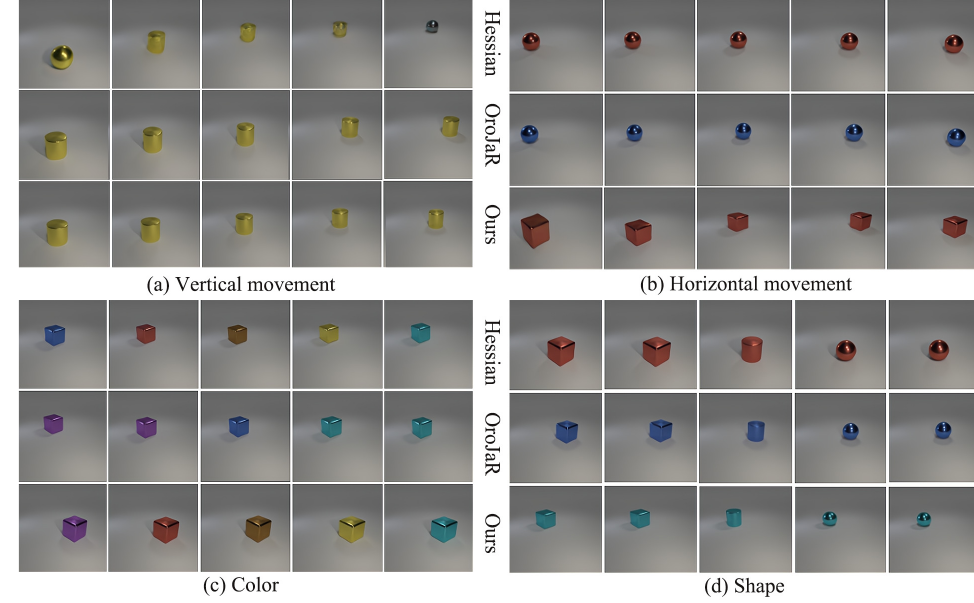
Figure 7. Comparison with OroJaR [14], Hessian penalty [13], and our method for the disentangle- ment quality of CLEVR Sample.